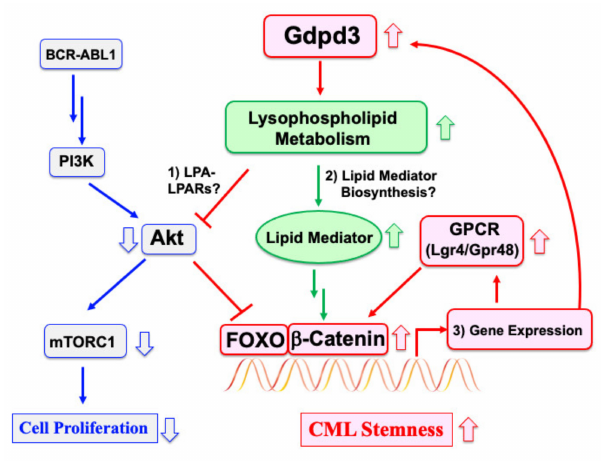
Figure 2. Regulation of CML stemness is independent of BCR–ABL1 oncogenic signaling. In the vast majority of mature CML cells, cell proliferation is driven by BCR–ABL1-mediated activation of the PI3K–Akt–mTORC1 signaling pathway. CML stem cells are able to maintain stem cell quies- cence despite possessing the oncogene and so are TKI resistant. We have shown that Gdpd3 and lysophospholipid metabolism are essential for maintaining CML stem cell functions in vivo. Elevated lysophospholipid metabolism contributes to CML stemness by regulating an interaction between active Foxo3a and β -catenin (although the exact mechanism remains unclear). It is possible that Gdpd3-mediated lysophospholipid metabolism: (1) suppresses Akt via an LPA–LPARs pathway; (2) contributes to the biosynthesis of lipid mediators; and/or (3) participates in a gene expression program involving Gdpd3 and GPCRs by FOXO/ β -catenin. Targeting any one of these elements of lysophospholipid metabolism specific to CML stem cells might provide fresh therapies to overcome disease relapse in many CML